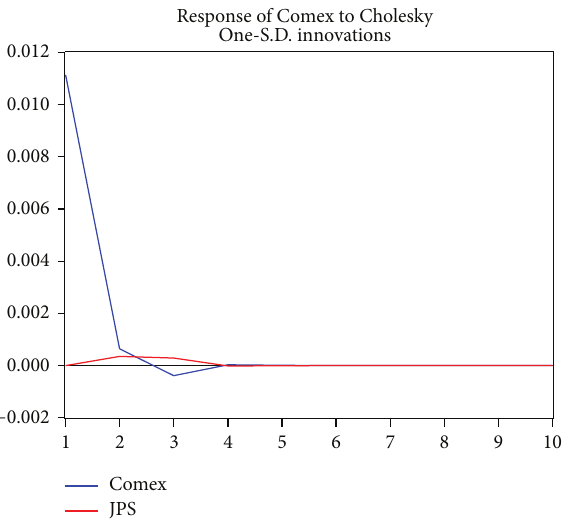
Figure 1: The impulse response function analysis graph of Comex.